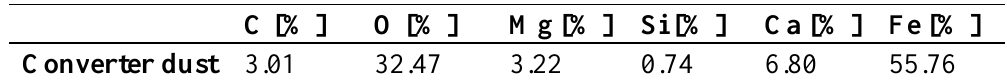
Table 3. Converter dust chemical composition, based on an energy dispersive X-ray spectrometry (EDS) investigation.